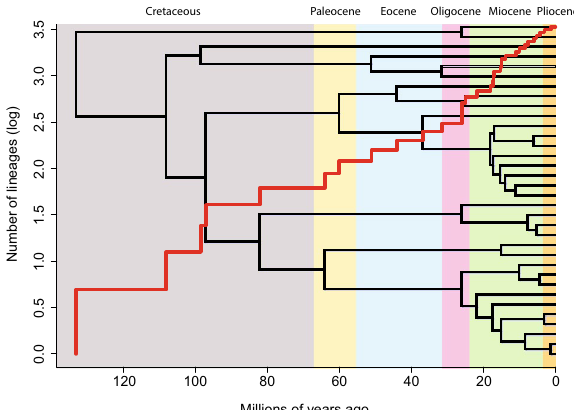
Figure 3. A lineage-through-time plot, showing species number accumulation (in red) on a logarithmic scale over the nephilid phylogenetic